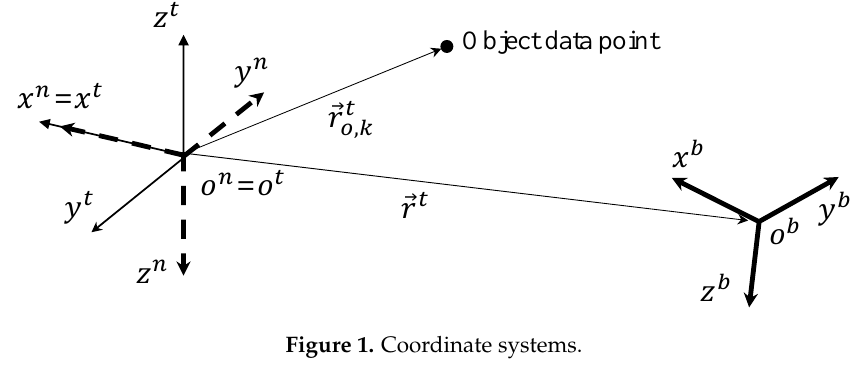
Figure 1. Coordinate